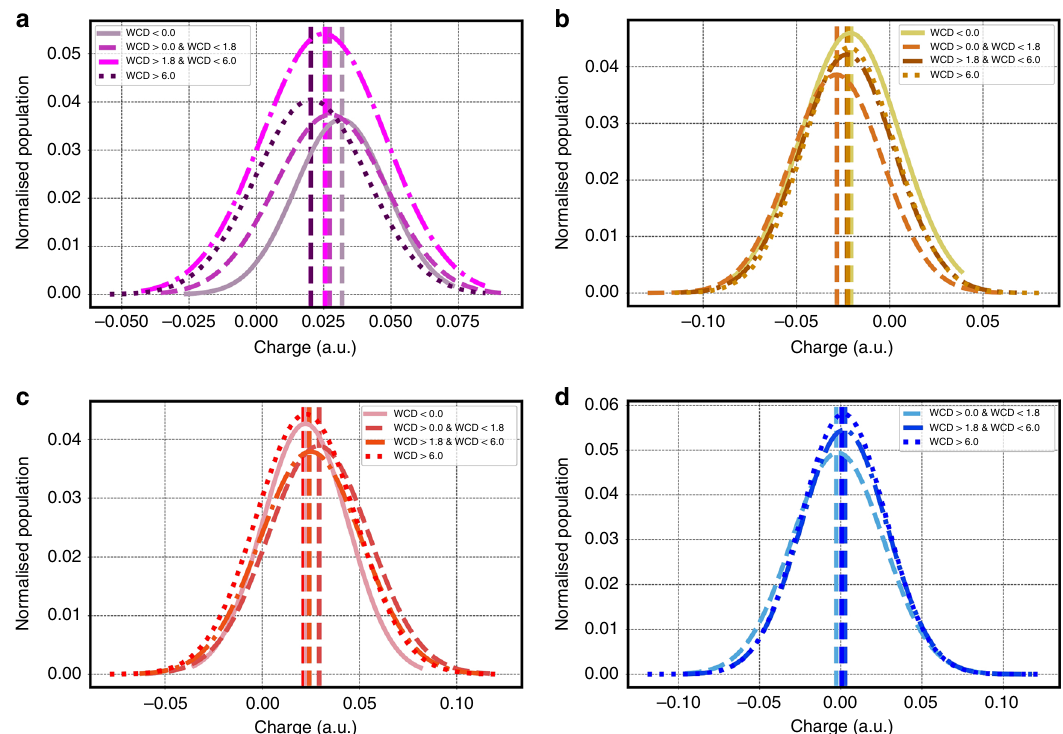
Fig. 4 Water/air layer-by-layer charge distributions. Layer-by-layer charge distributions of the 1in-out ( a ), 1in-2out ( b ), 2in-1out ( c ), and 2in-2out ( d ) water molecules for the water – air interface. The fi rst moment is highlighted by a vertical line for each